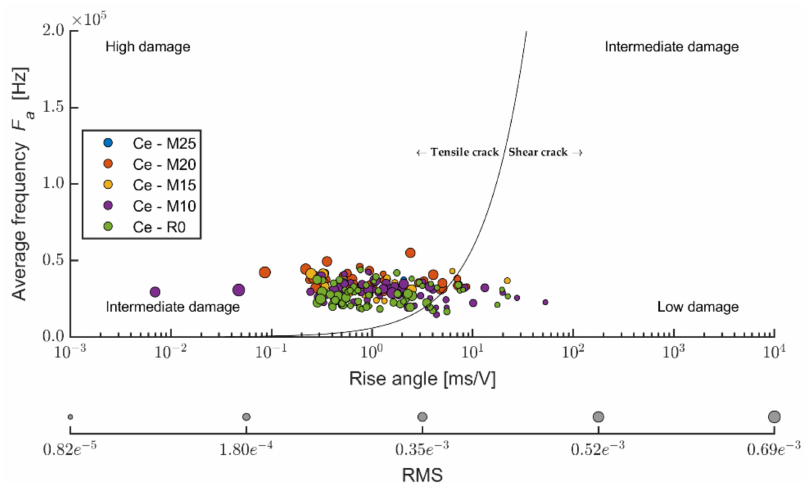
Figure 18. Comparison of average frequency and RA values—relation between tensile and shear cracks in monitored area of test specimens; mixture Ce (reference boards) before and after frost/defrost cycles.